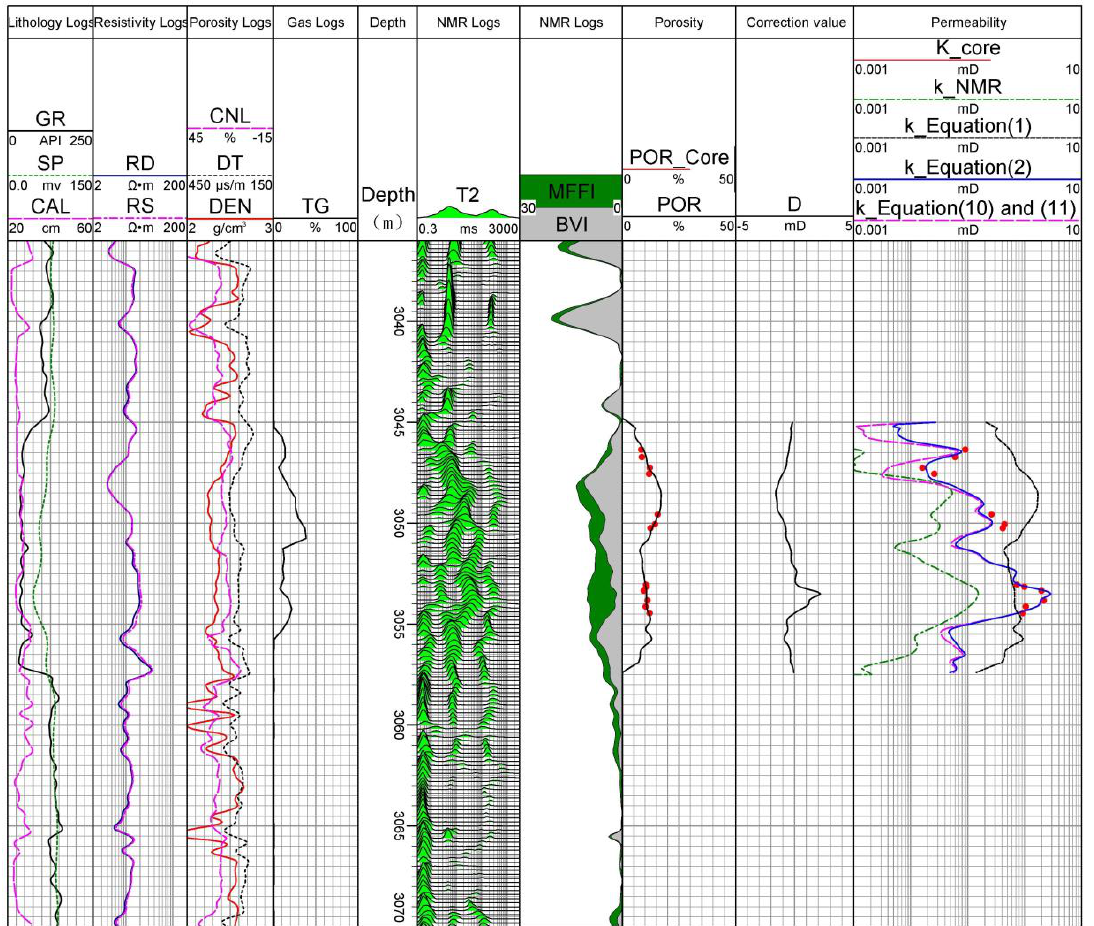
Figure 8. The results of permeability calculation of the JX well. K_core represents core sample permeability; K_NMR represents permeability calculated by NMR logs; K_Equation (1) represents permeability calculated by Equation (1); K_Equation (2) represents permeability calculated by Equation (2); and K_Equation (10) and (11) represents permeability calculated by Equation (10) and Equation (11)—that is, when the calculation results of both are positive, the calculation result of Equation (10) is selected, and when Equation (10) calculates a negative value, it is replaced by the result of Equation (11). In the upper part of the reservoir at 3045–3051 m, the permeability value obtained from Equation